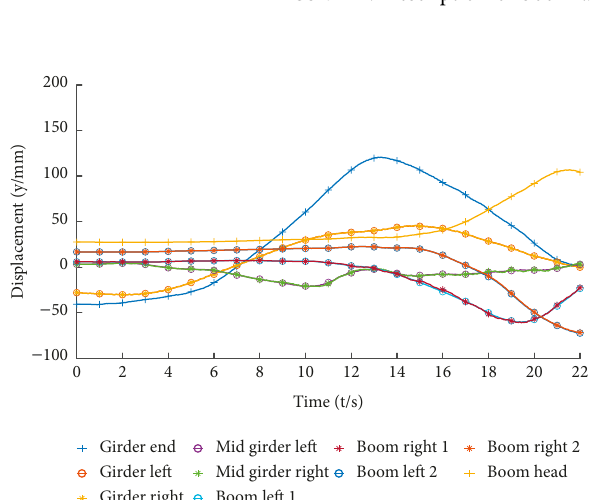
Figure 14: Description of boom and girder measure points and directions.